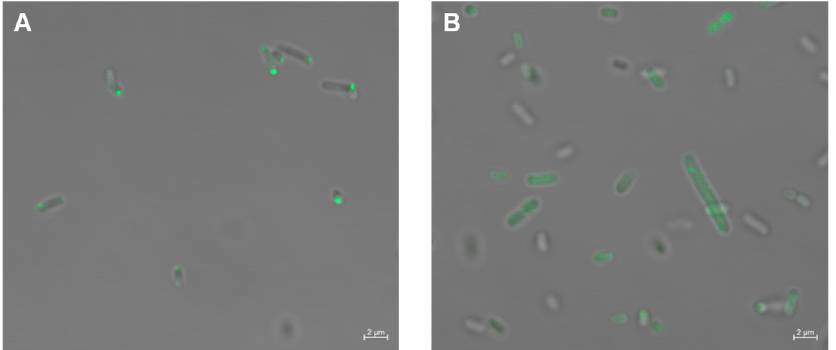
Figure 2. Cellular localization of MCP 514 . Plasmid expressing the eGFP–MCP 514 fusion protein was introduced into A. fabrum MCP 514 -deficient mutant ∆ 514 ( A ) and E. coli strain DH5 α ( B ), respectively. Bacterial cells were grown to middle-log phase and observed by using confocal laser-scanning microscopy.